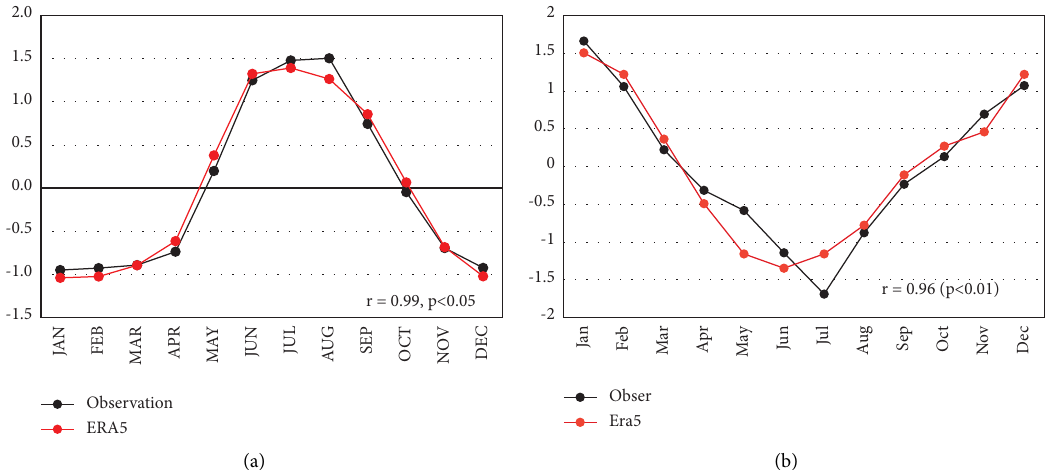
Figure 3: Te mean annual cycles of standardized (a) monthly rainfall and (b) mean sea level pressure of the ERA5 and observed stations rainfall datasets, which averaged over longitudes 92 ° E–103 ° E and latitudes 10 ° N–30 ° N for the period